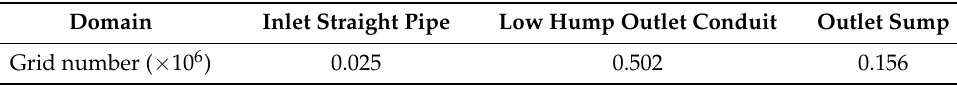
Table 2. Grid distribution of computational